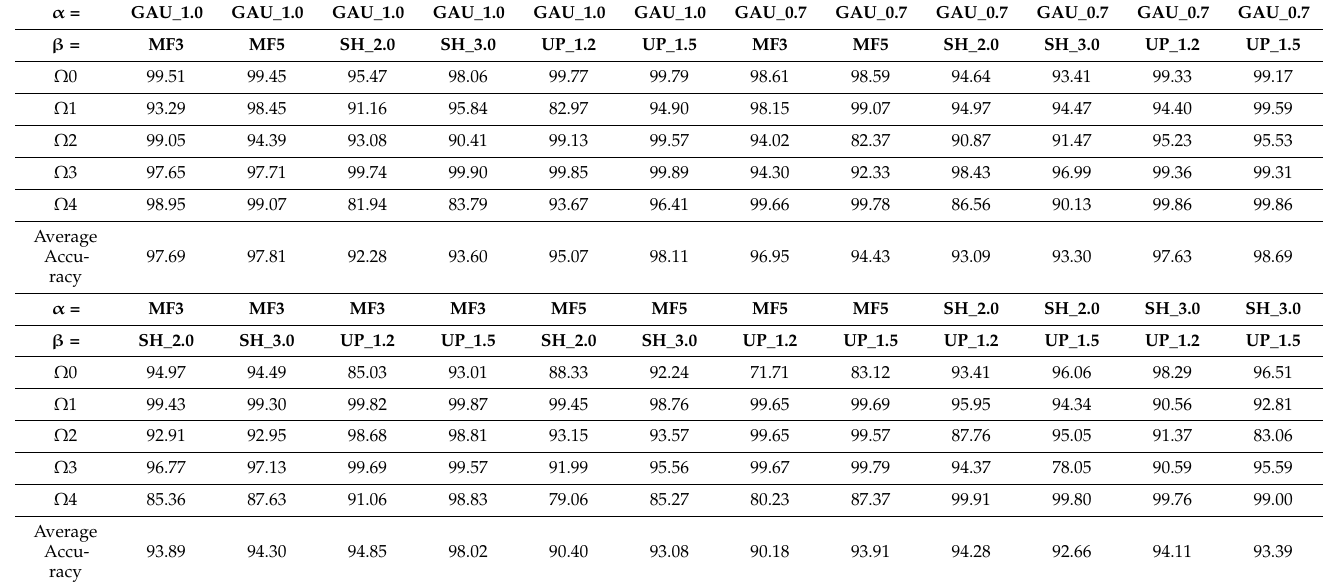
Table 1. Operator sequence detection with similar specifications.